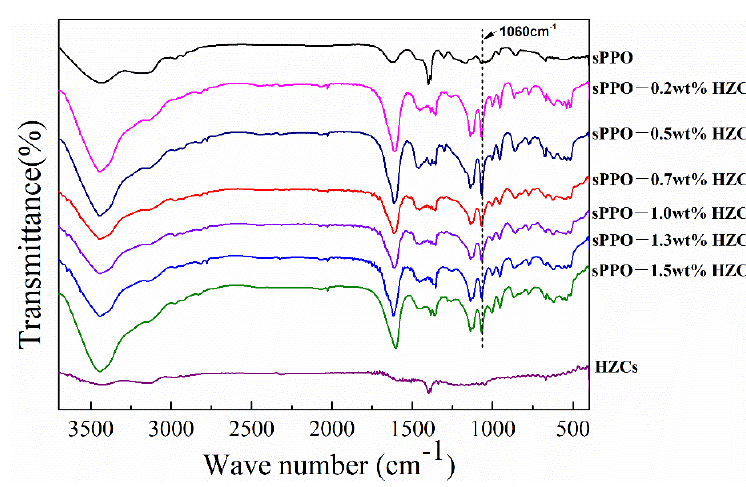
Figure 4. FTIR spectra of nanocomposite membranes.